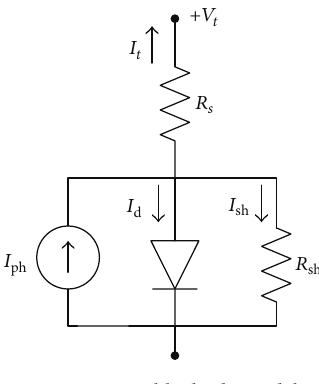
Figure 2: Double diode